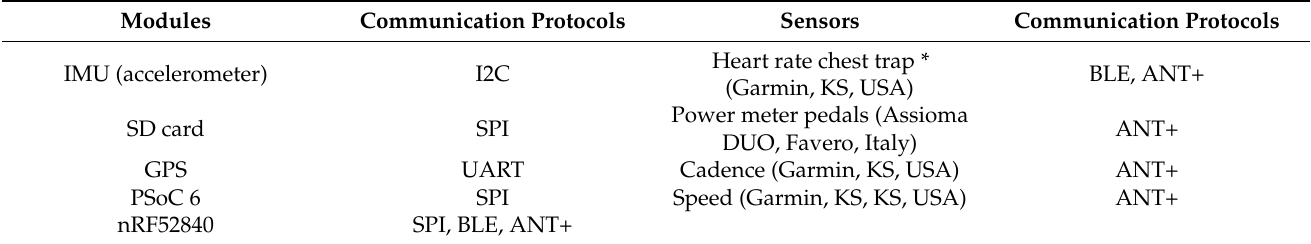
Table 3. List of all sensors and modules with their respective communication